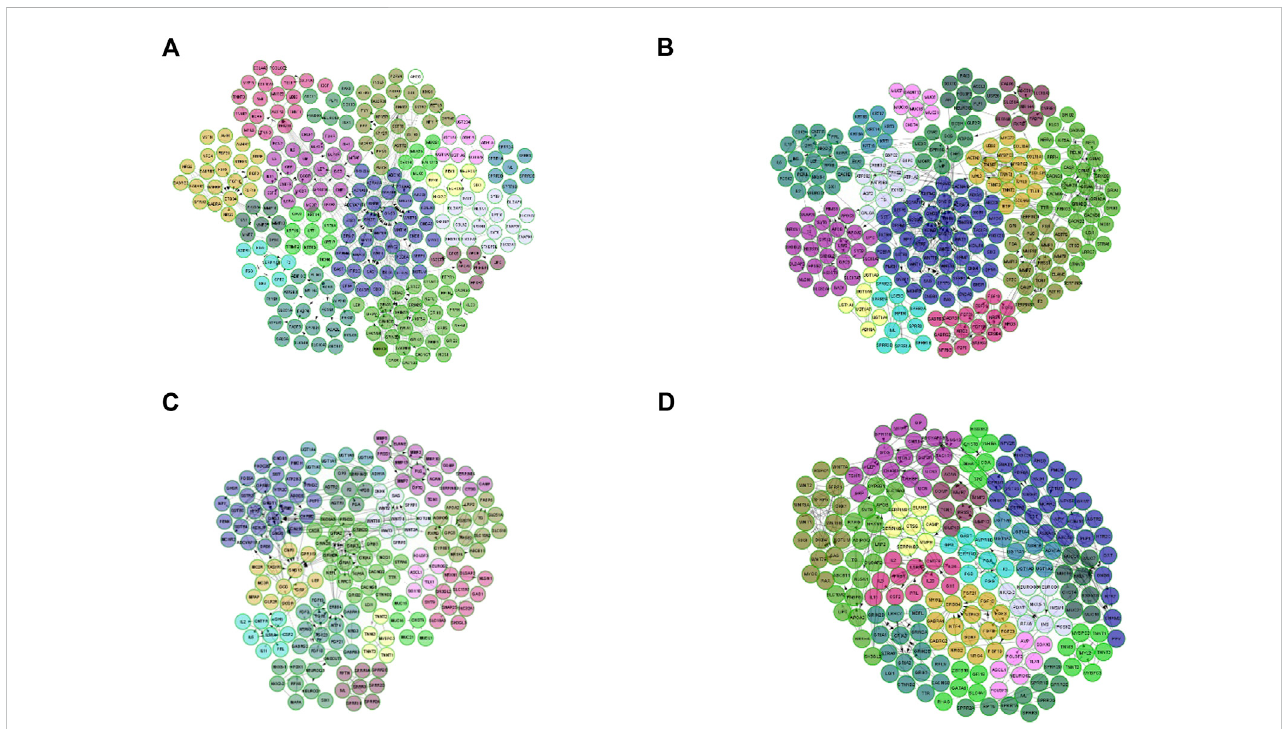
FIGURE 3 FInetworkforeachstage,whereeachnodeisadifferentiallyexpressedgeneandedgerepresentstheinteractionbetweengenes. (A) istheFInetworkfor stage I, (B) represents the FI network built by DEG-Stage II, (C) and (D) are the FI network for stage III and stage